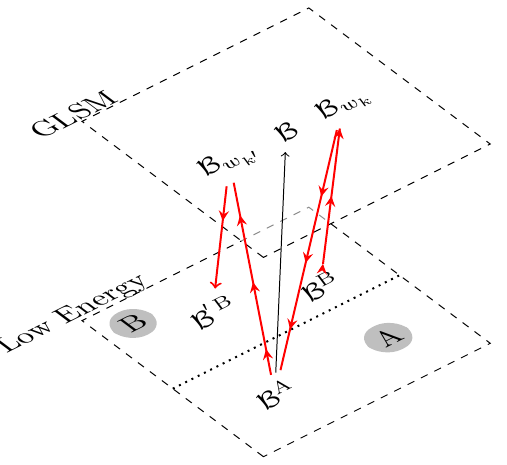
Figure 3 . Analytic continuation of a brane in phase A to phase B via di(cid:11)erent